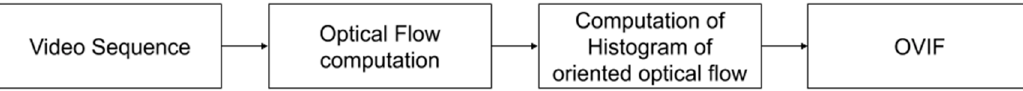
Figure 1. Descriptive diagram of the steps to calculate the ovif features [2].